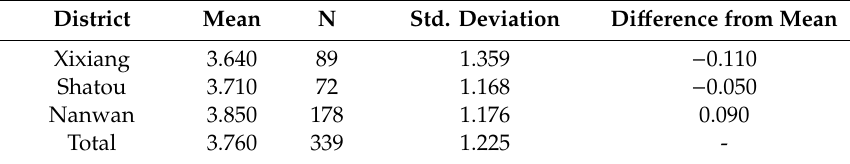
Table 3. Comparison of protective coping behavior intention between di ff erent